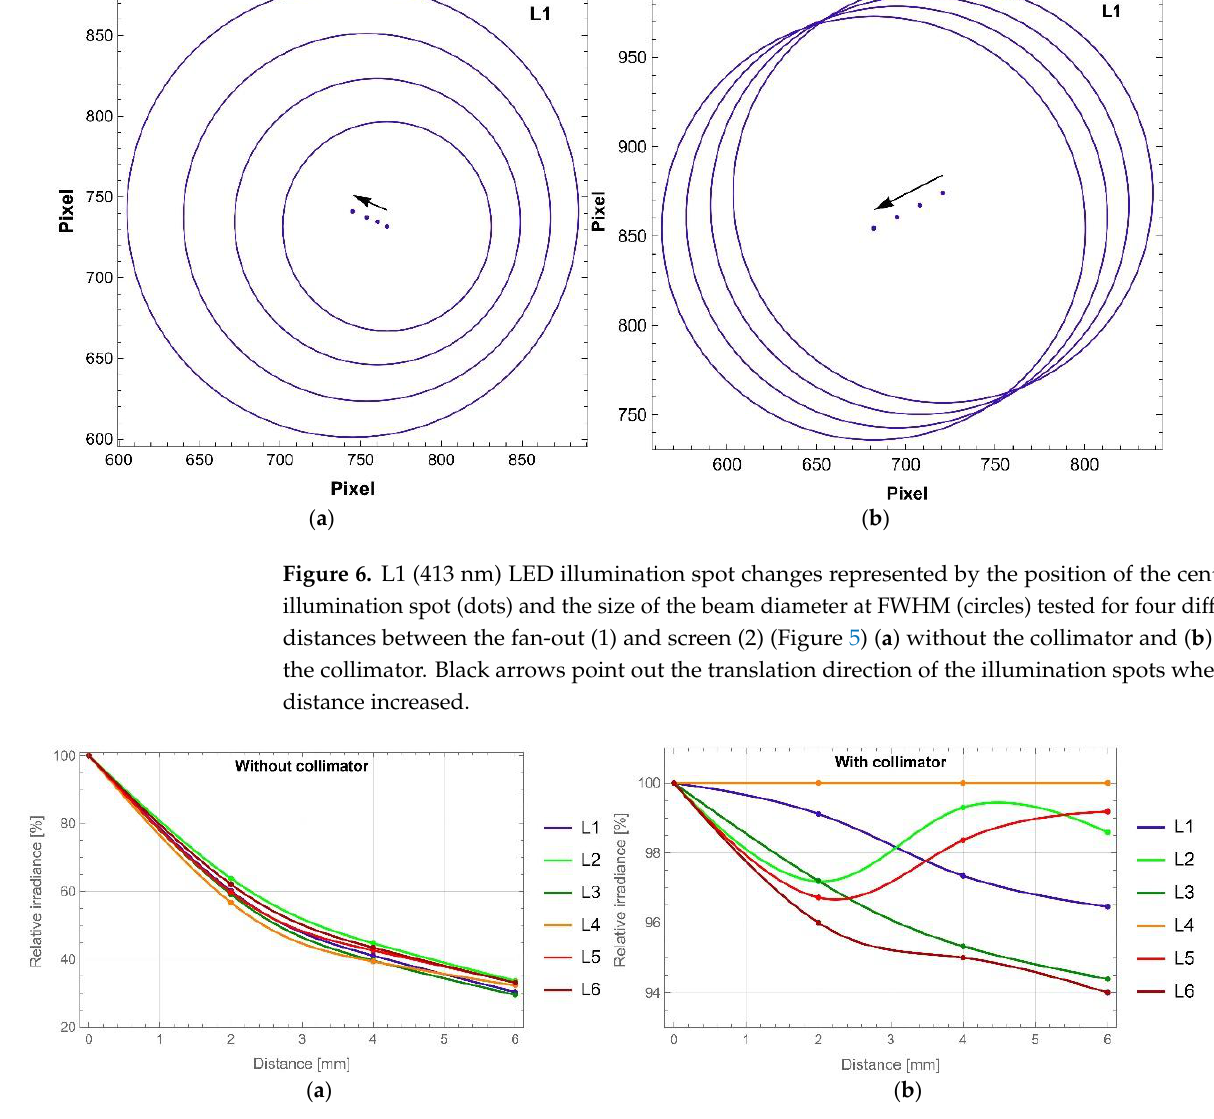
Figure 7. Relative LED irradiance differences are dependent on the distance measuring head – object; measuring head ( a ) without and ( b ) with the collimator. measuring head ( a ) without and ( b ) with the